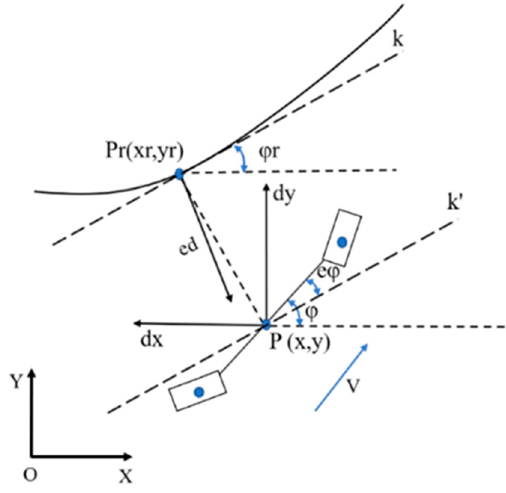
Figure 8. Lateral deviation and heading deviation.